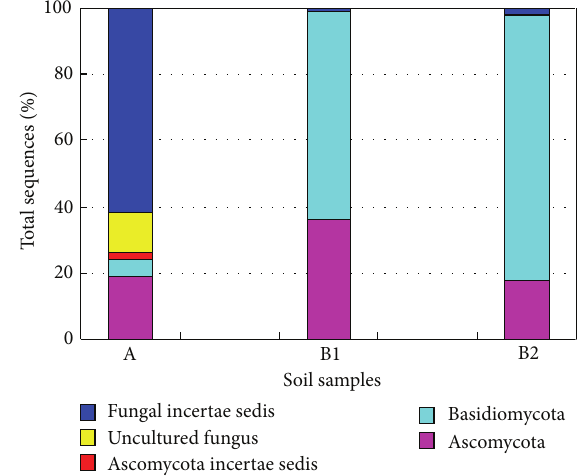
Figure 1: Comparison of fungal communities for original and enriched soil samples. An original soil sample from native rain for- est; B1 enriched soil with natural lignocellulose biomass for 8 days; B2 enriched soil with natural lignocellulose biomass for 15